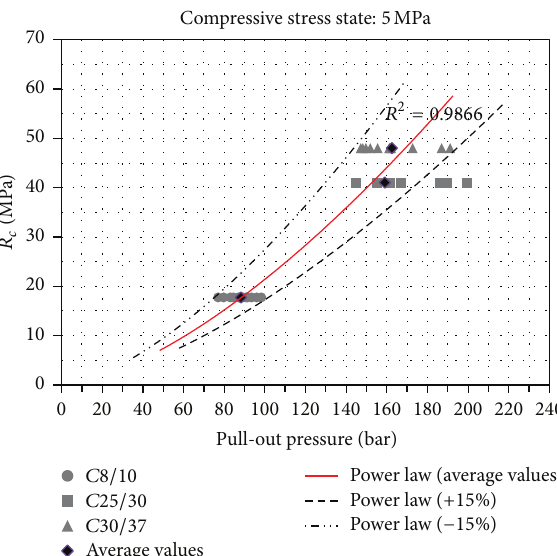
Figure 13: Calibration curve for 5 MPa uniform compression stress.